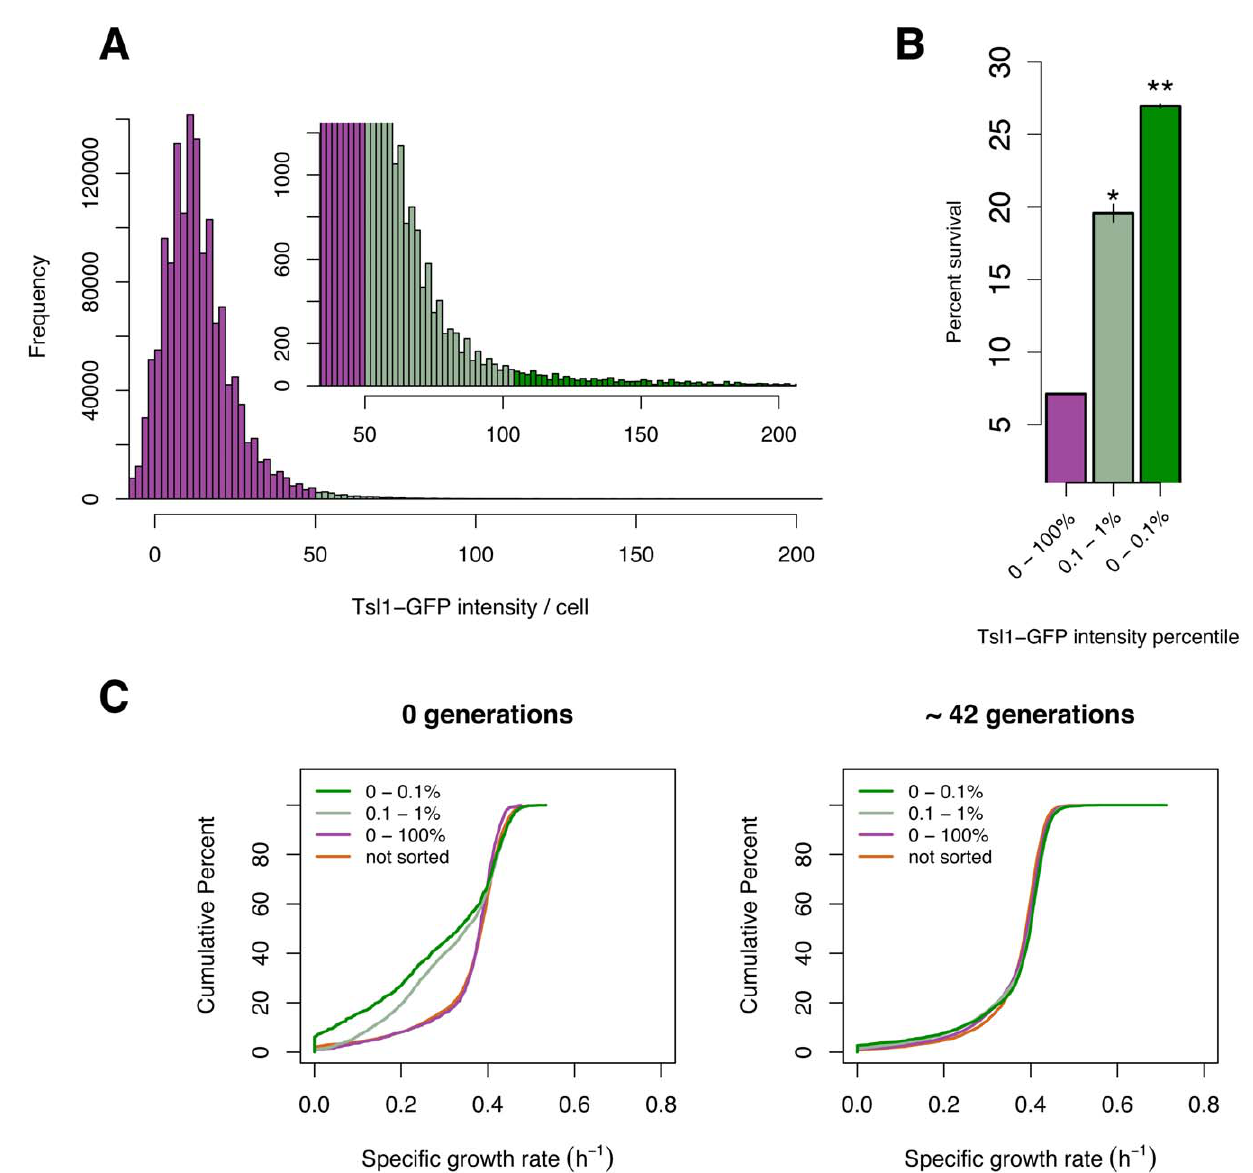
Figure 4. Cell sorting by Tsl1-GFP content alters growth rate distributions and heat shock survival. (A) The distribution of Tsl1 abundance does not appear bimodal. Histogram of single-cell Tsl1-GFP intensity as measured by fluorescence-activated cell sorting. Inset: the right- hand tail of the main figure. Cells with the top 0.1% (dark green) and next 0.1 to 1% (light green) Tsl1-GFP fluorescence were sorted for downstream analysis. (B) Survival of sorted populations following heat shock of a liquid suspension as measured by plating on agar plates. p -Values are a comparison to the unsorted population (purple), Student’s t test of arcsin transformed data: *, p , 0.01; **, p , 1 6 10 2 5 . Error bars indicate SEM. (C) Sorting for Tsl1-GFP abundance transiently alters growth rate distributions. Left: cumulative growth rate distributions of sorted cells (dark and light green), cells passed through the cell sorter but unsorted (purple), and cells not passed through the cell sorter (orange). Right: Samples of the same sorted or unsorted cell populations after , 42 generations of